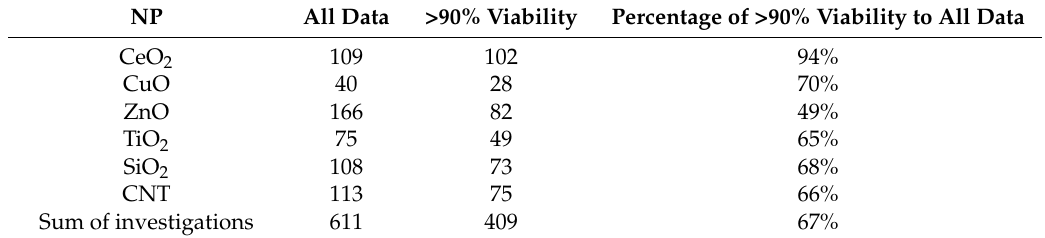
Table 1. Number of investigations according to each NP in total and the >90% viability